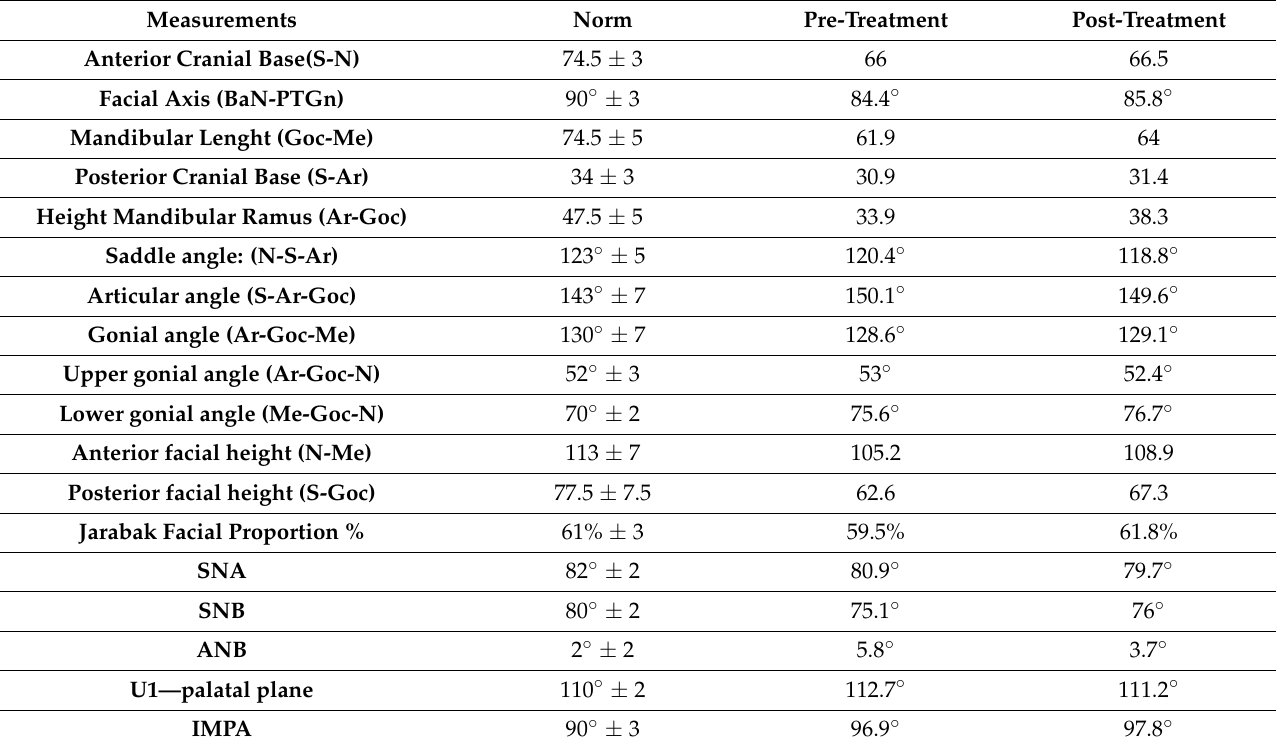
Table 2. Cephalometric measurements pre and post treatment. A: Point A; B: Point B; S: Saddle; N: Nasion; Pg: Pogonion, SN: Sella-Nasion Plane, MP: Mandibular plane; U1: Upper central incisor; IMPA: incisor mandibular plane angle.